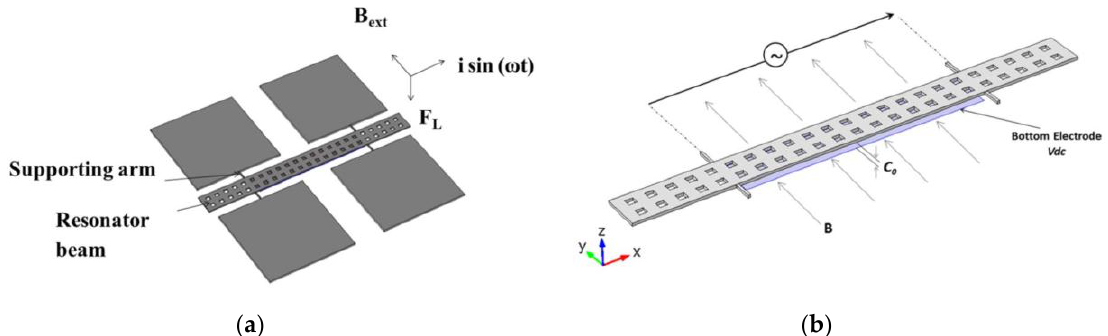
Figure 18. Schematic of the: ( a ) operation principle of a xylophone resonator; and ( b ) its electrical connections for capacitive sensing [31]. Reprinted with permission from [31]. Copyright© 2016, Springer International Publishing AG.